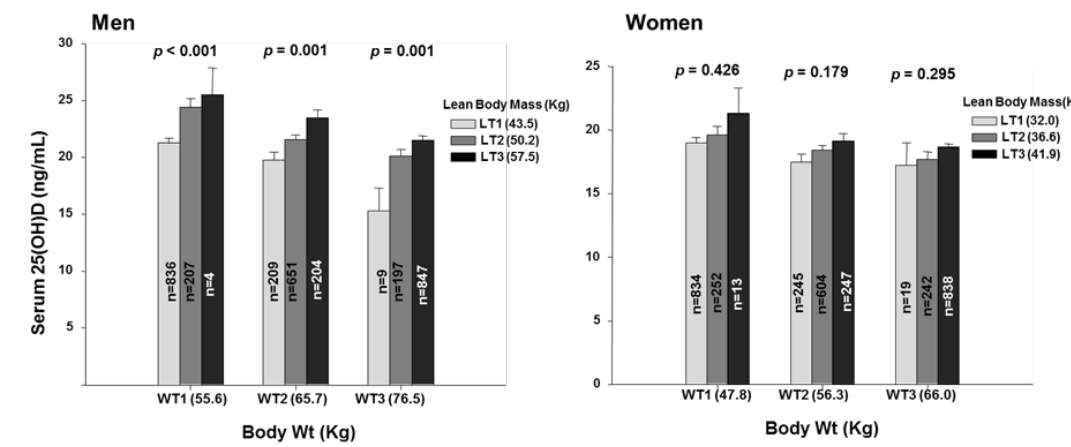
Figure 5. Serum 25-hydroxyvitamin D concentrations by lean body mass tertiles within each body weight tertile categories. 25(OH), 25-hydroxyvitamin D; WT1, the first tertile of body weight (55.6 Kg, 31.9–61.6 Kg for men and 47.9 Kg, 32.3–52.7 Kg for women); WT2, the second tertile of body weight (65.7 Kg, 61.7–69.8 Kg for men and 56.3 Kg, 52.8–59.8 Kg for women); WT3, the third tertile of body weight (76.5 Kg, 69.9–108.6 Kg for men and 66.0 Kg, 59.9–100.0 Kg for women); Bar plots in which each body weight tertile categories represent tertiles of lean body mass (LT1, the first tertile of lean body mass, 43.5 Kg, 26.7–47.5 Kg for men and 32.0 Kg, 24.2–34.8 Kg for women; LT2, the second tertile of lean body mass, 50.2 Kg, 47.6–53.0 Kg for men and 36.6 Kg, 34.8–38.4 Kg for women; LT3, the third tertile of lean body mass, 57.5 Kg, 53.1–76.4 Kg for men and 41.9 Kg, 38.4–56.2 Kg for women). Data plotted represent mean and standard deviation. p for trend in same groups are from general lineal model in complex data analysis.